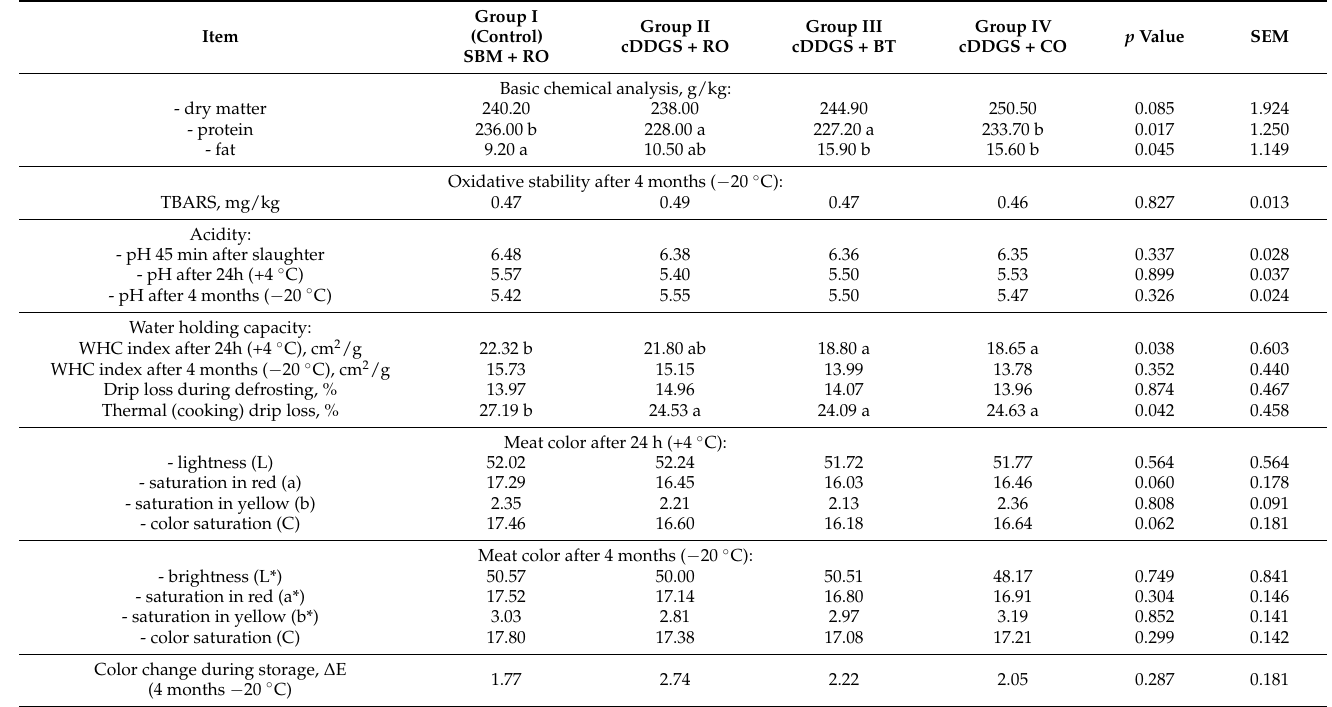
Table 3. Meat quality traits ( longissimus m.)